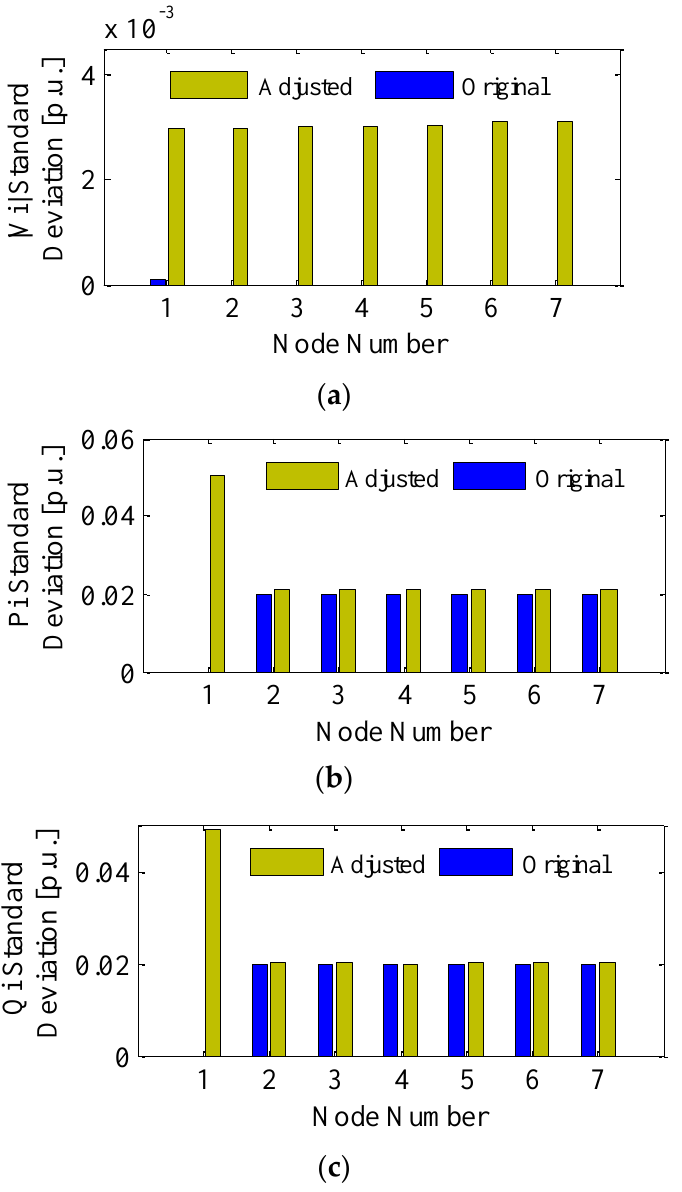
Figure 6. Original weight in the conventional estimator and adjusted weights in the adaptive data tolerant estimator. ( a ) |𝑉 𝑖 | ; ( b ) 𝑃 𝑖 ; ( c ) 𝑄 𝑖 .